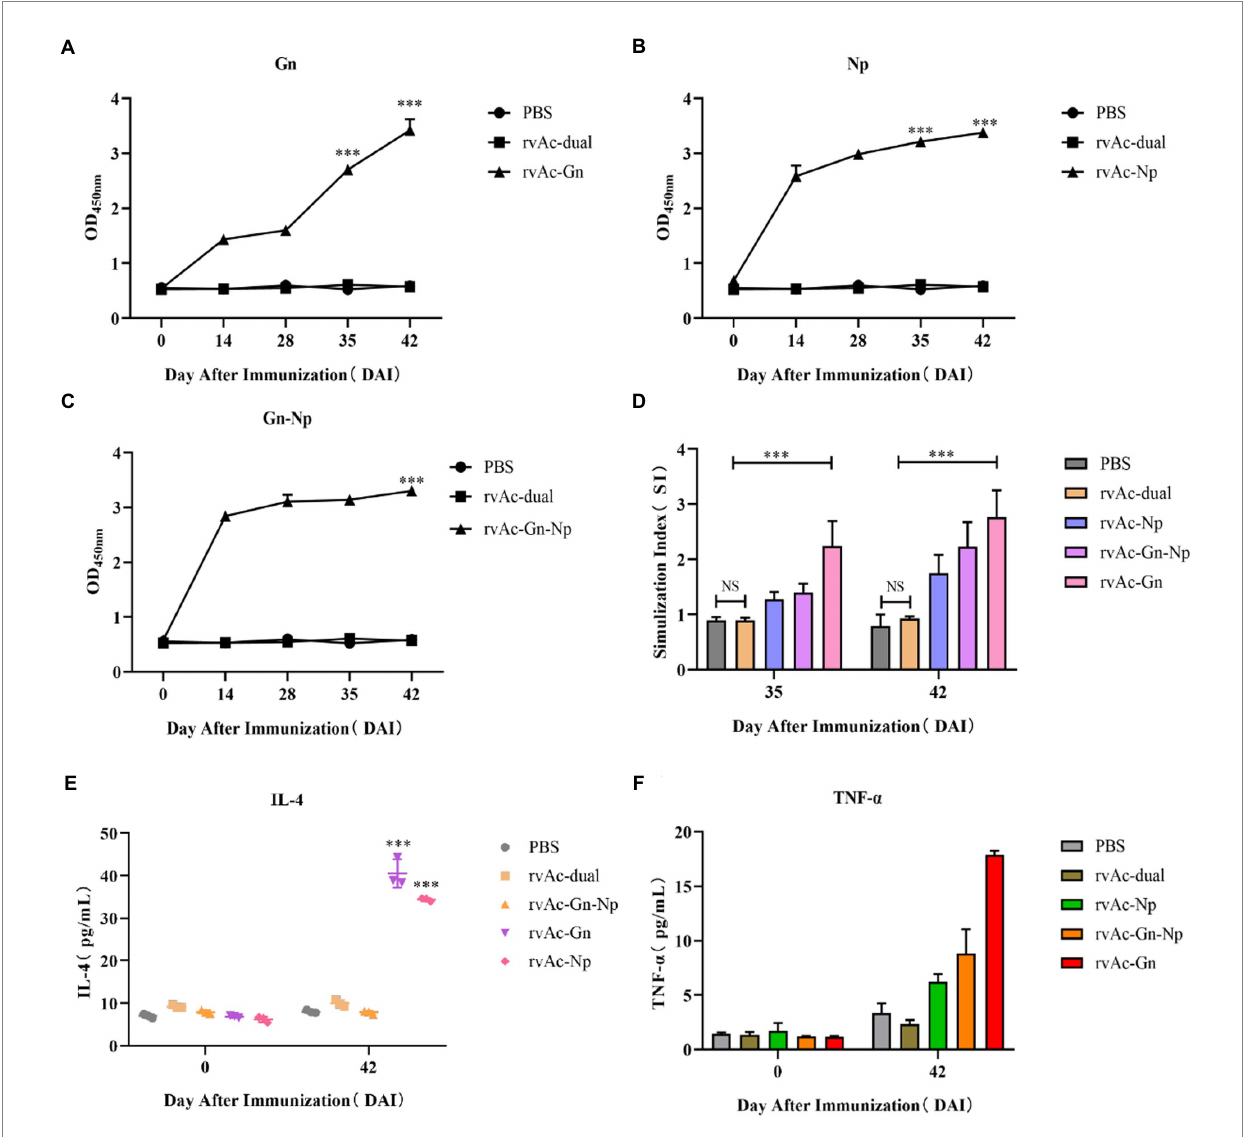
FIGURE 7 Immunogenicity analysis of mice. The immunogenicity of four groups of recombinant baculovirus-infected mice was evaluated by measuring the serum IgG levels (A–C) . (A) Anti-Gn protein IgG levels. (B) Anti-Np IgG levels. (C) Anti-Gn-Np IgG levels. The X-axis indicates the number of days the serum samples were collected after immunization, and the Y-axis indicates the mean OD450 of the serum samples. (D) For the splenic lymphocyte stimulation assay, the data in the figure represent the stimulation indices of splenic lymphocyte samples collected at 35 and 42 DAI, and the assay was repeated three times for all the samples. The data are presented as the means + variances ( N = 4). NS, no significant difference; *** p < 0.001, significant difference (Bonferroni assay). To further evaluate the cellular immune responses of the baculovirus-infected mice, the serum IL-4 (E) and TNF- α (F) levels were measured. The data in the graph represent the total serum levels of the cytokines in the samples collected at 0 days and 42 days. The assay was repeated three times for all the samples, and the error bars represent the standard deviations (SDs). *** p < 0.001, highly significant difference compared with the rvAc-dual PBS group (Bonferroni